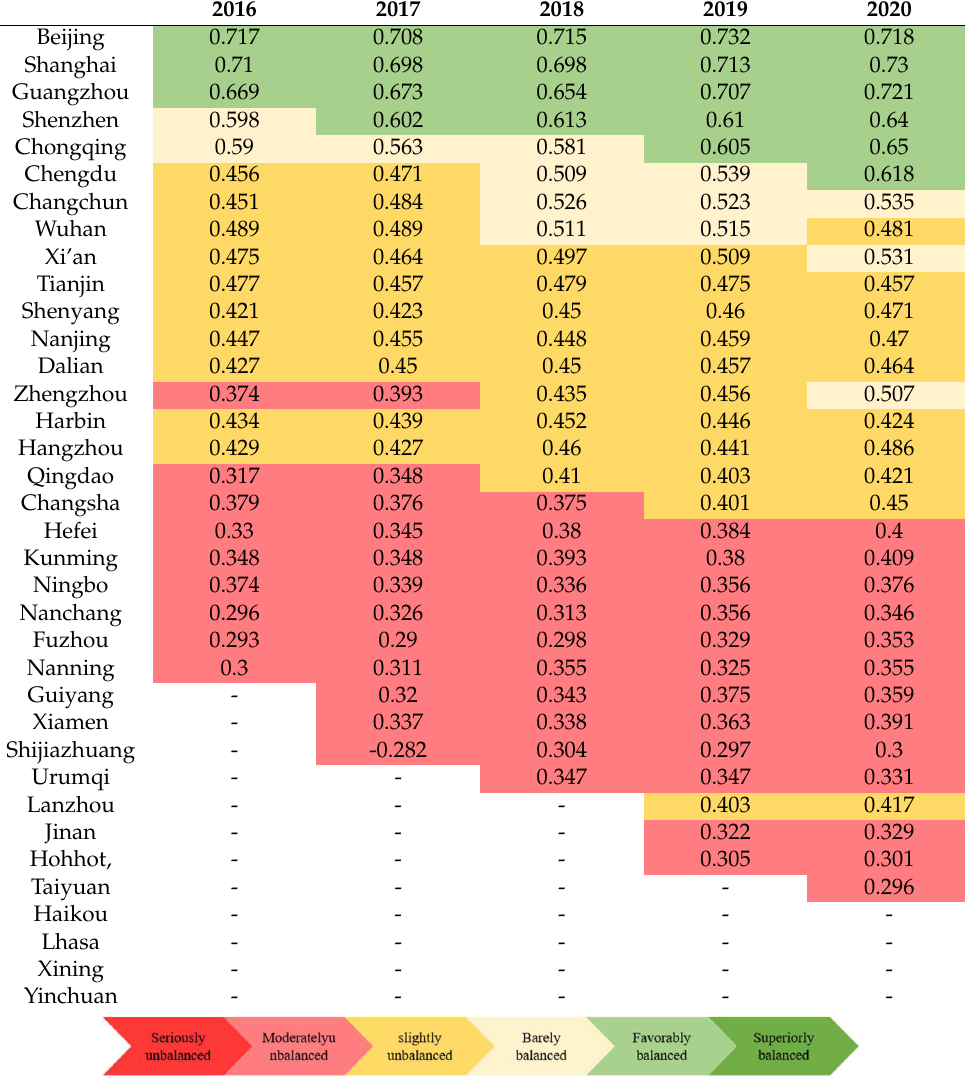
Table A1. Coupling coordination degree among B-R-T in 36 cities in China. Note: “-” represents no final data result for the corresponding cities.